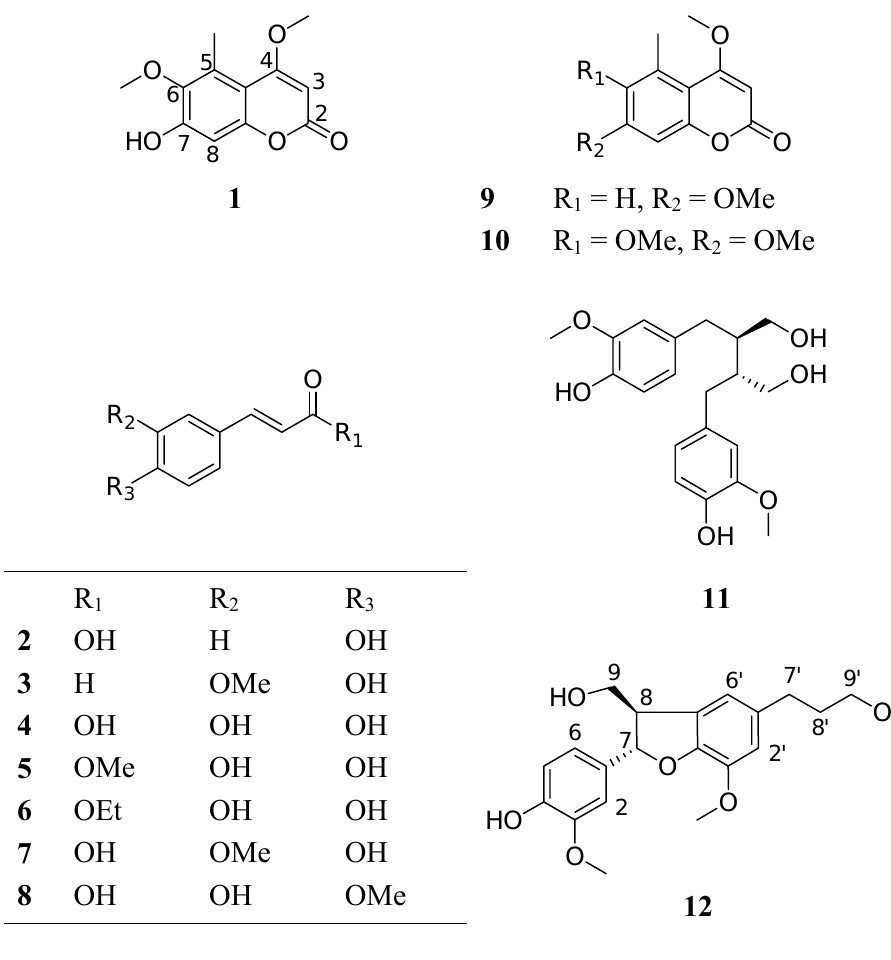
Figure 1. The structures of compounds